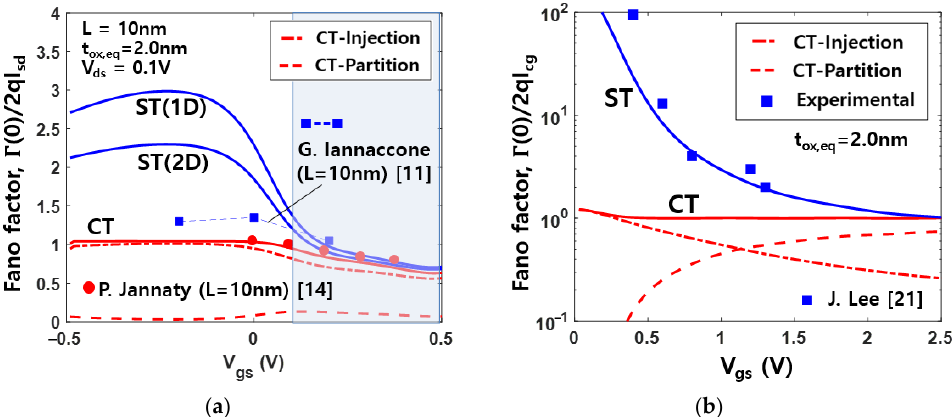
Figure 3. Comparison between ST model and CT model of Fano factor as a function of V gs for ( a ) SD current noise and ( b ) gate tunneling current noise